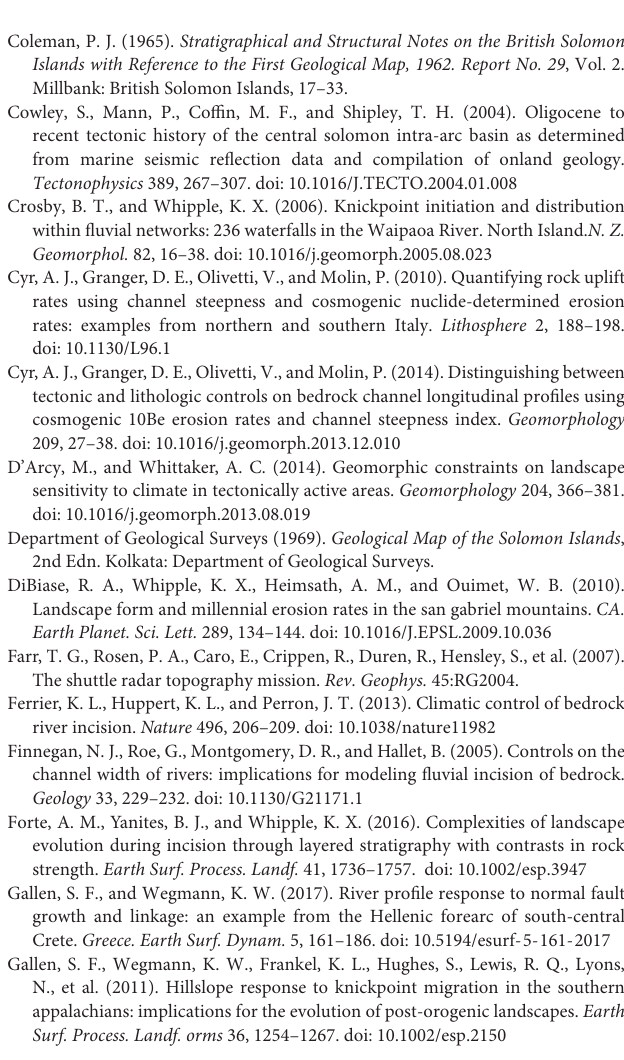
FIGURE S1 | River long profiles for the island of Guadalcanal. See Figure 5 for location of each river. FIGURE S2 | River long profiles for the island of Makira. See Figure 10 for location of each